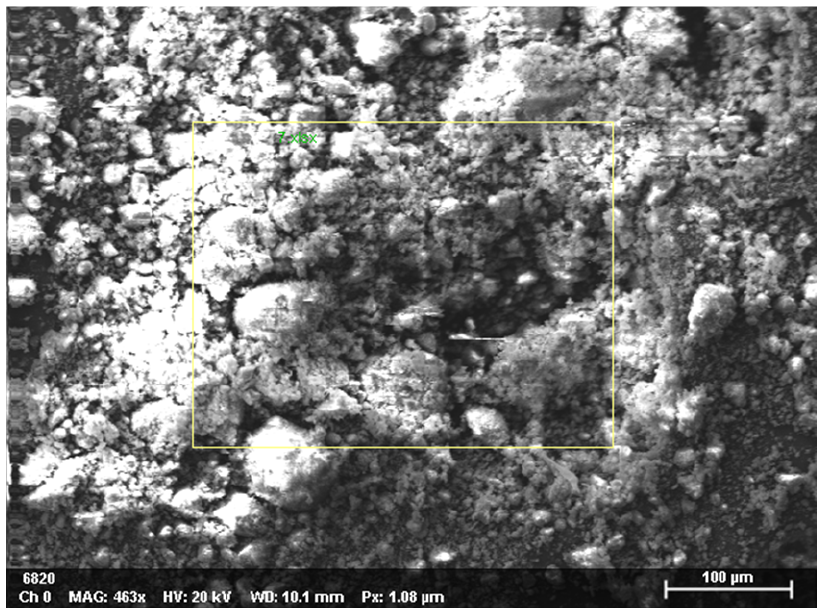
Figure 3. SEM image of the gangue.